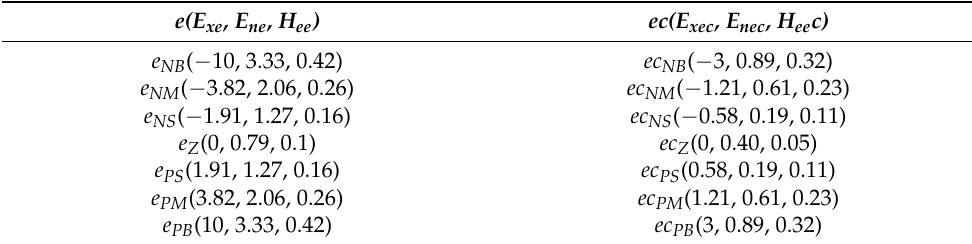
Table 4. Digital characteristics for input